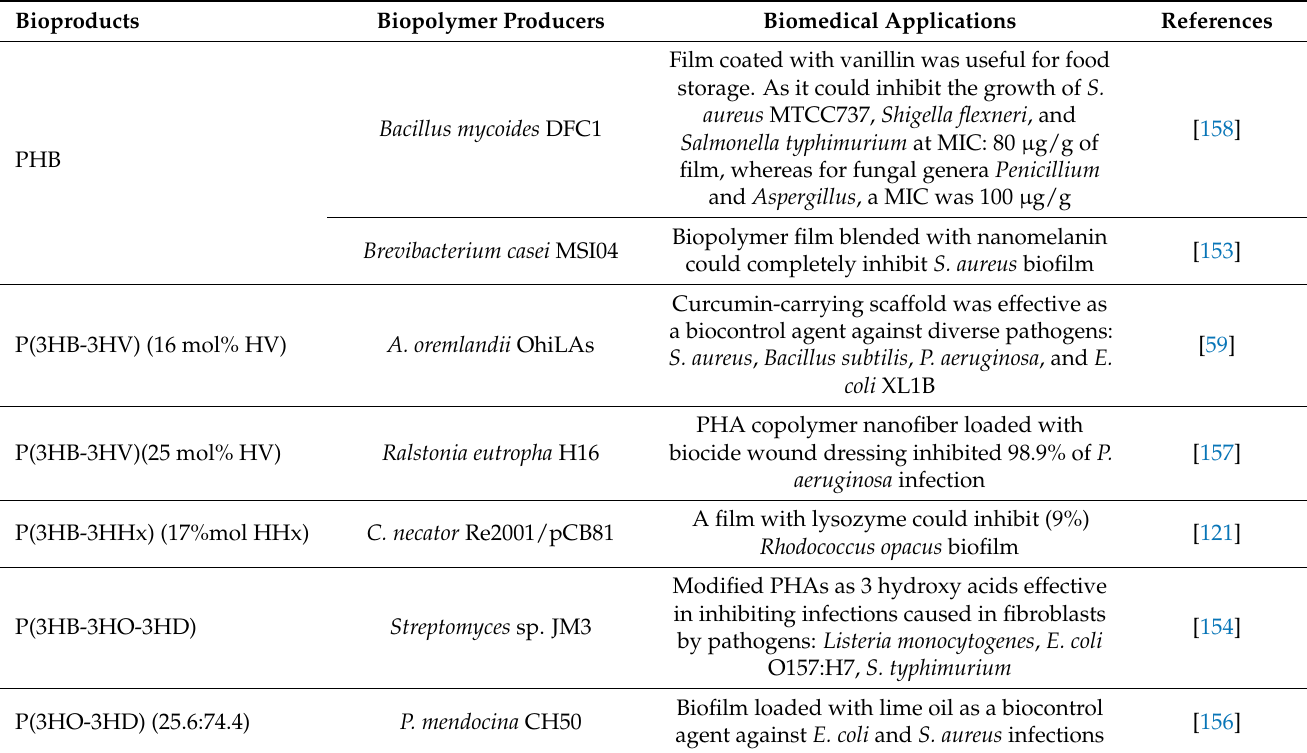
Table 3. Diversity of biomedical applications of polyhydroxyalkanoates and their derivatives as biocontrol